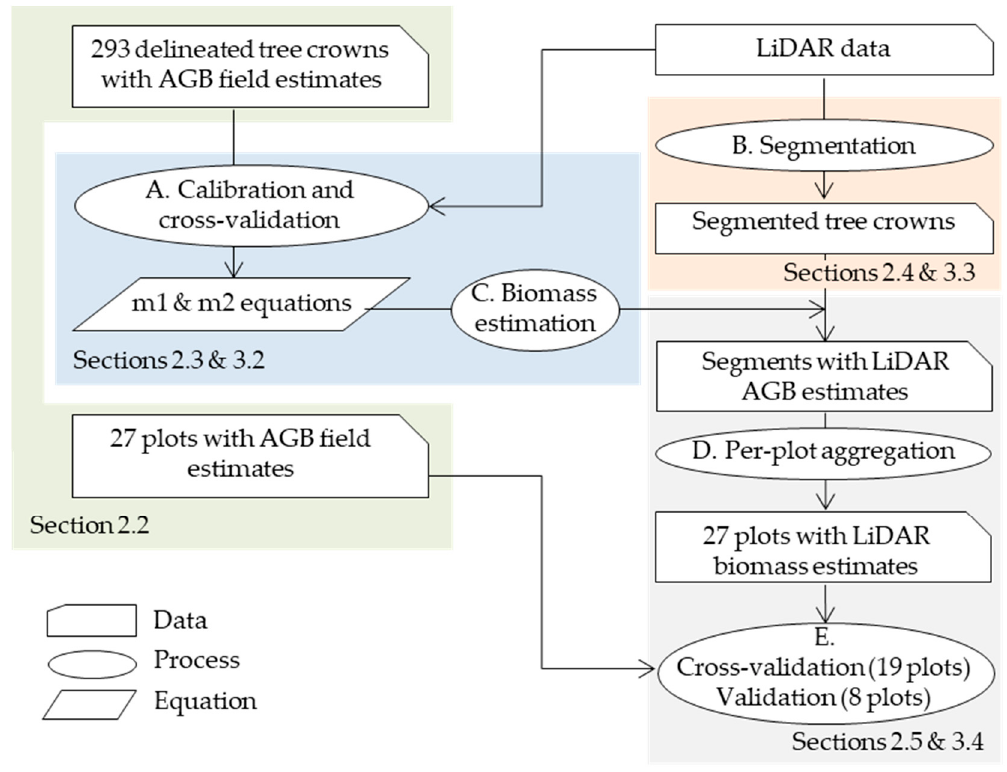
Figure 3. General workflow for the validation of biomass remote sensing estimates. ( A – E ) Processes are described in the text of Section 2.5.